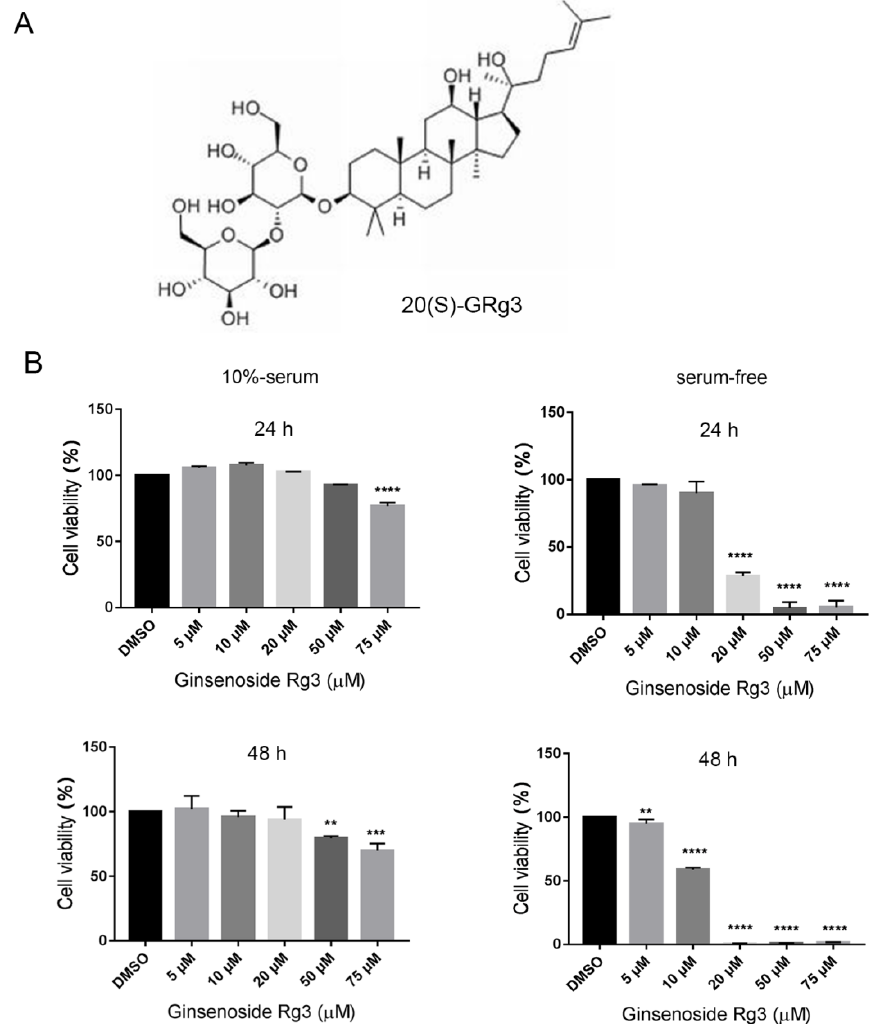
Figure 1. 20( S )-GRg3 inhibits the proliferation of serum-starved HeLa cells. ( A ) Chemical structure of 20( S )-GRg3. ( B ) Effects of treatment with 20( S )-GRg3 at various concentrations and different